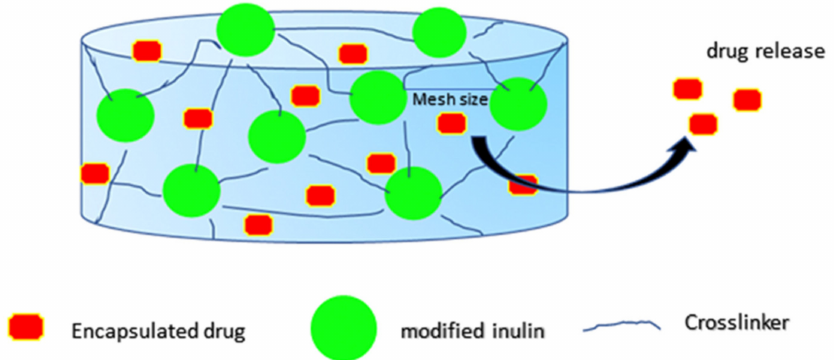
Figure 3. Hydrogel releasing of encapsulated